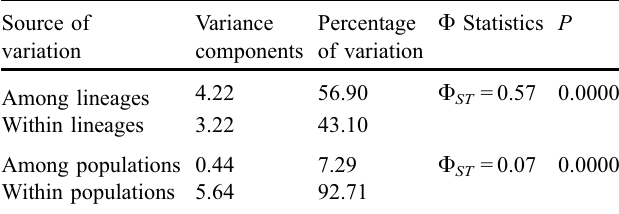
Table 2. Analysis of molecular variation in T.